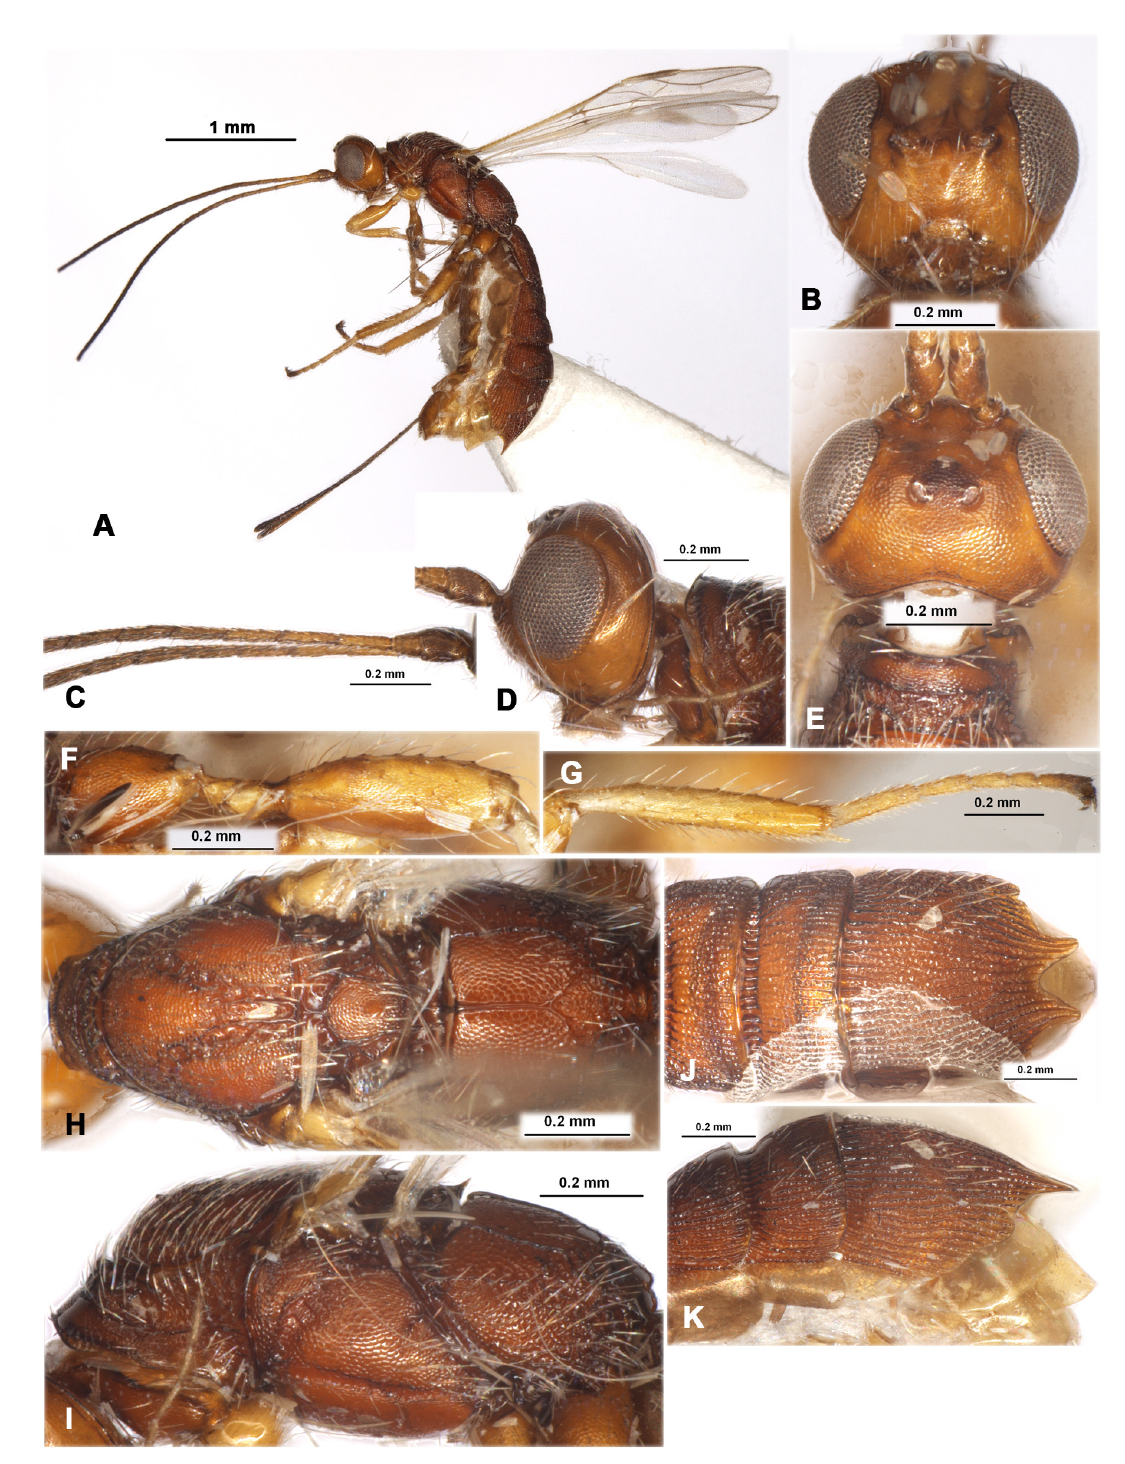
Fig. 61. Rhaconotus ( Rh. ) vanharteni Belokobylskij sp. nov., holotype, ♀ (RMNH). A . Habitus, lateral view. B . Head, front view. C . Basal segments of antenna. D . Head, lateral view. E . Head and anterior part of mesosoma, dorsal view. F . Hind coxa and femur. G . Hind tibia and tarsus. H . Mesosoma, dorsal view. I . Mesosoma, lateral view. J . Third to fifth metasomal tergites, dorsal view. K . Third to fifth metasomal tergites, lateral